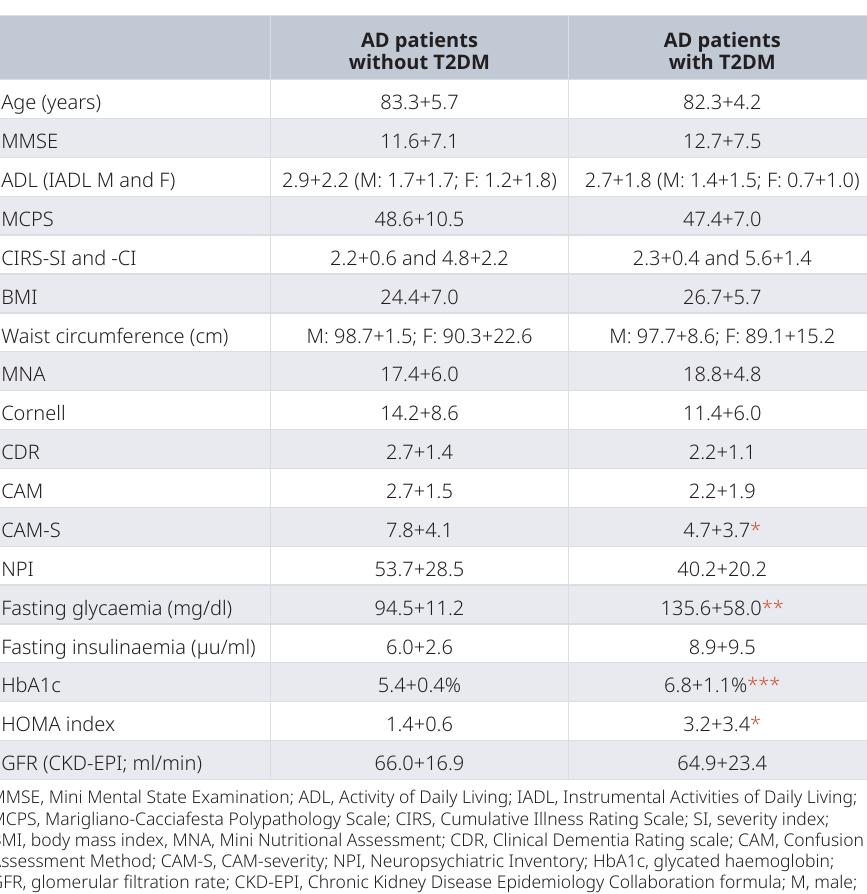
Table 1. Clinical characteristics in Alzheimer’s disease (AD) patients with (n = 16, females n = 9) and without (n = 22, females n = 18) type 2 diabetes (T2DM) (mean+standard